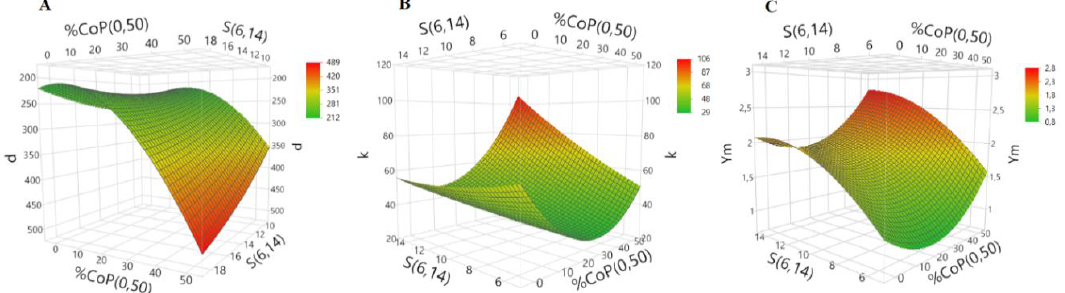
Figure 2. Surface responses for ( A ) bulk density ( d , kg m − 3 ), ( B ) thermal conductivity ( k , mW · m − 1 · K − 1 ) and ( C ) Young’s modulus ( Y m, MPa).